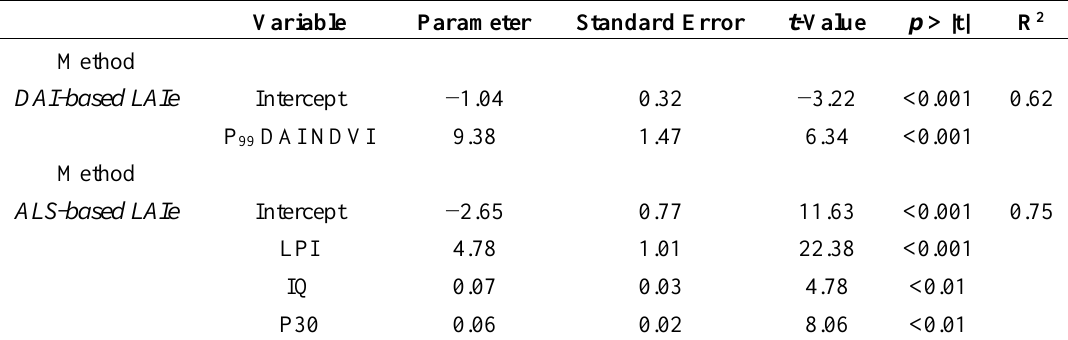
Table 5. Results of the best models obtained for the estimation of LAI from ALS- and DAI-based metrics